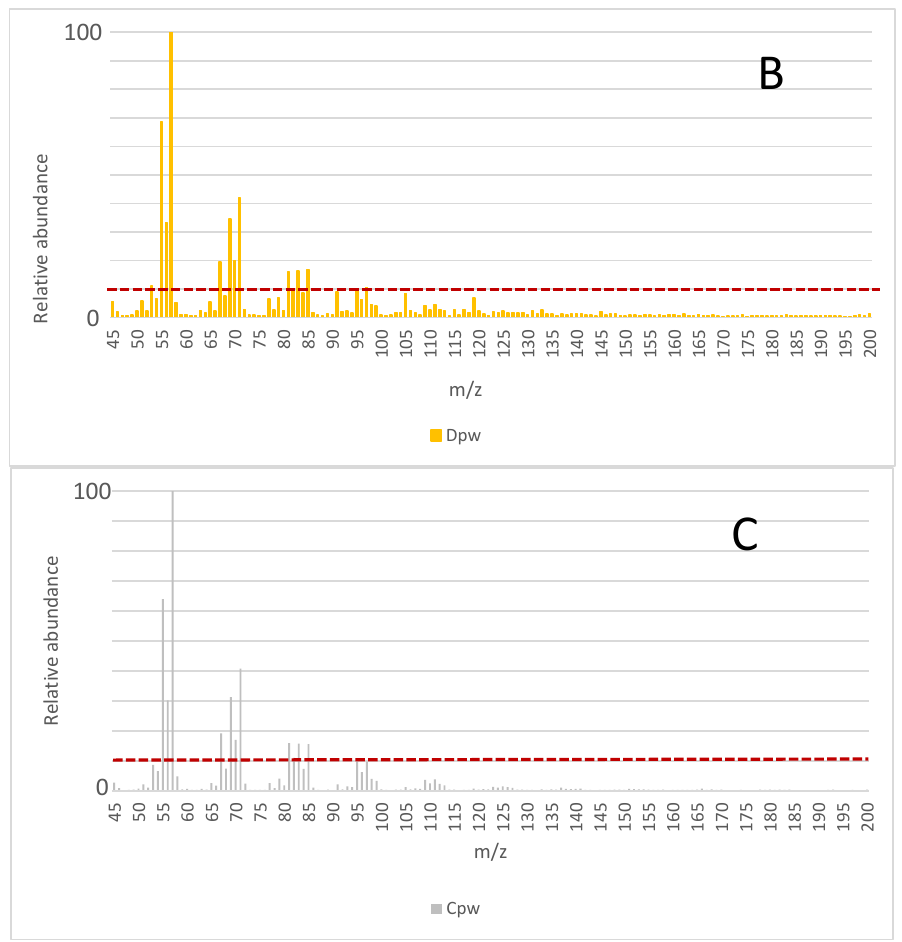
Figure 1. Spectra for the burned samples: Gpw ( A ); Dpw ( B ); and Cpw ( C ). Average values for all assayed incubation temperatures and incubation times. The m / z values with an intenisty above the red line were considered for the optimization.